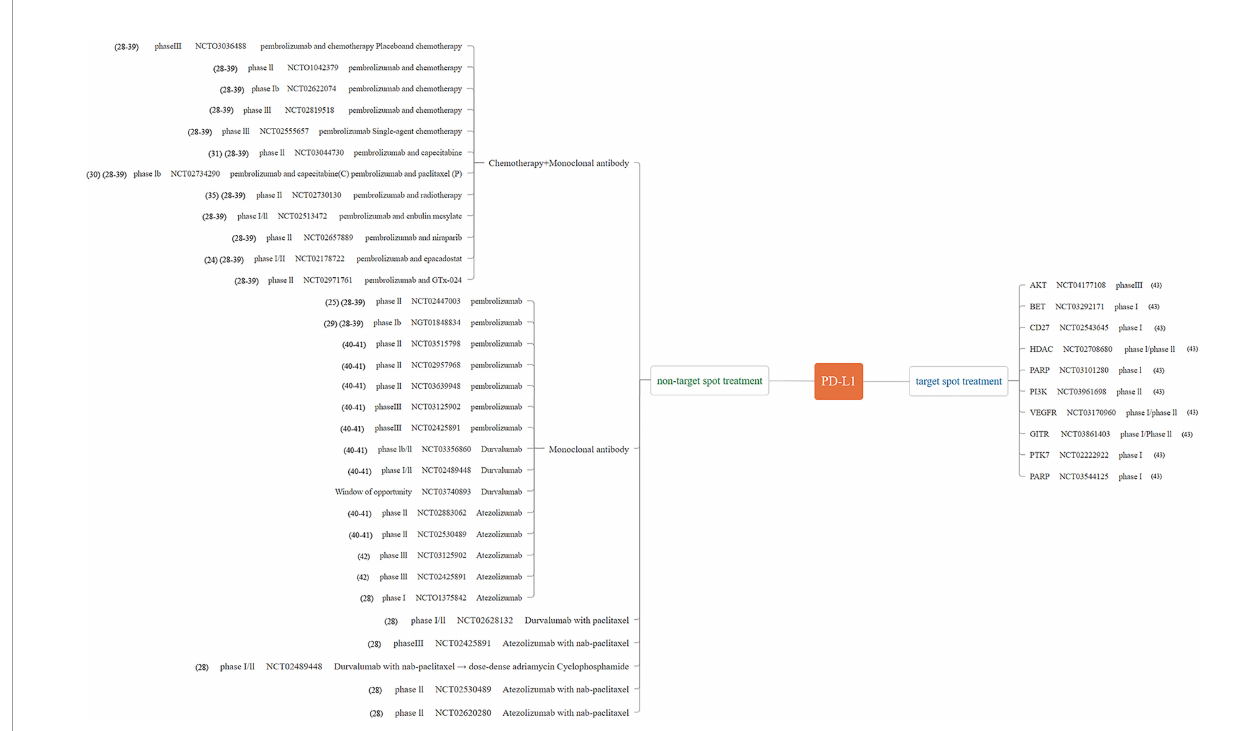
FIGURE 3 | Major published clinical trials using PD-L1 inhibitors in